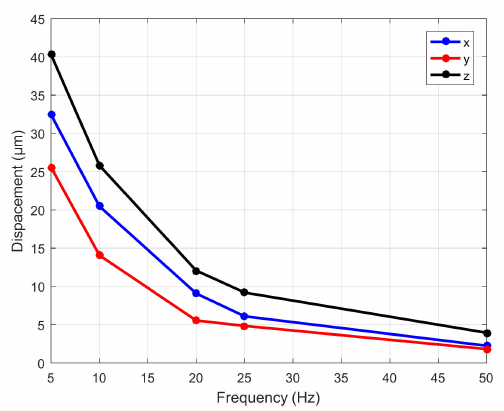
Figure 14. Variation of frequency and output trajectory amplitude.